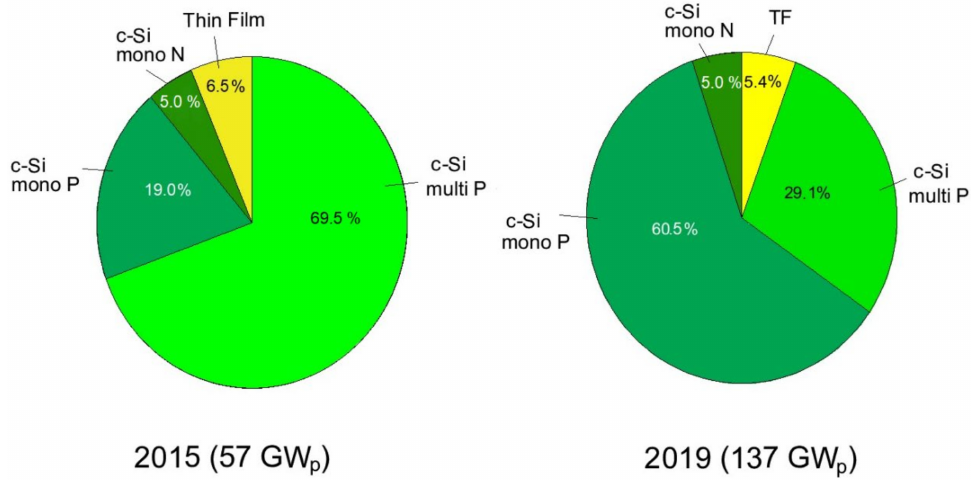
Figure 3. Global comparison of PV technologies in their total production [21].